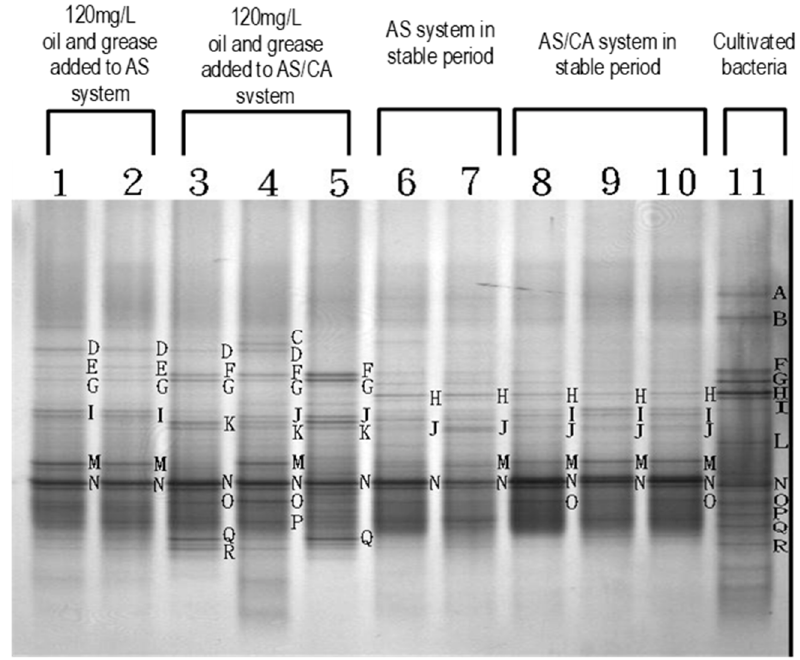
Figure 10. Denatured gradient gel electrophoresis (DGGE) in AS system and AS / CA system after 120 mg / L of oil and grease are added and in stable period.